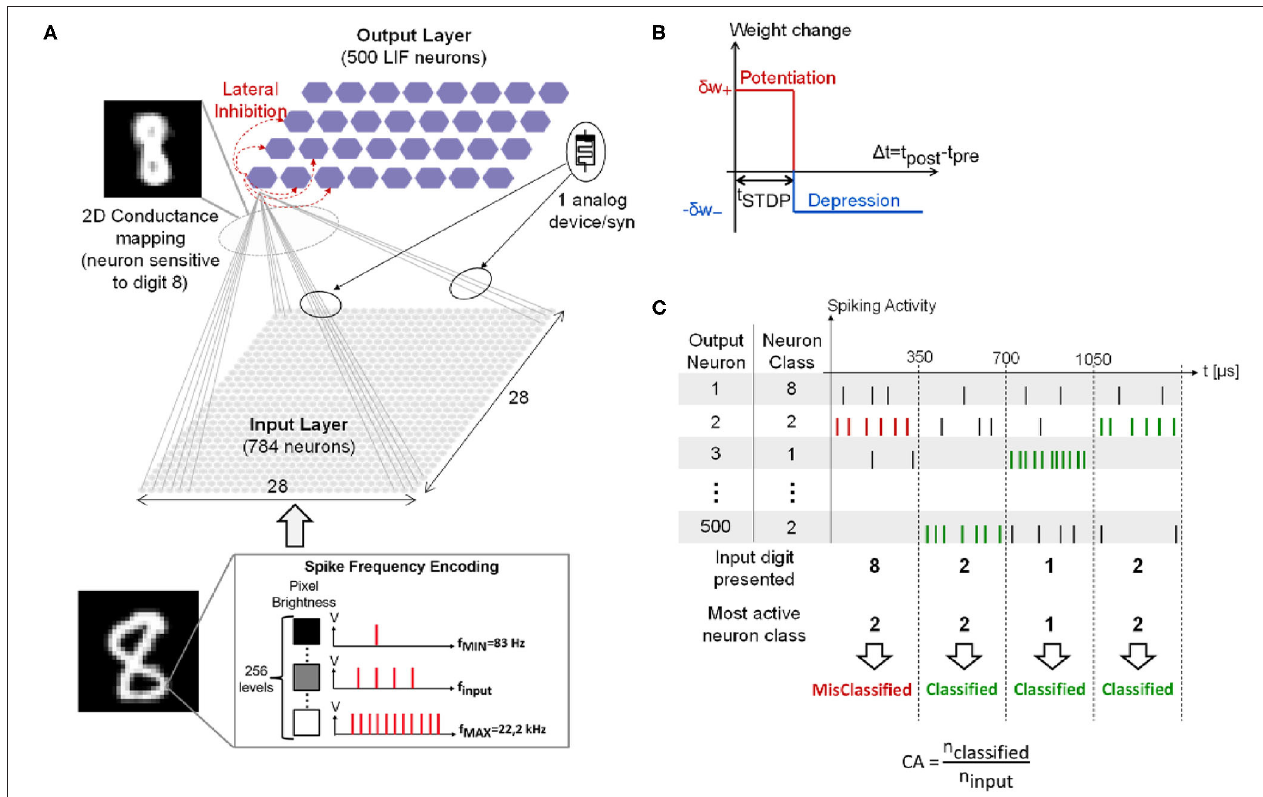
FIGURE 1 | (A) Simulated SNN for the MNIST classification. (B) Simplified STDP learning rule. (C) Example of spiking activity of four output neurons when four different input digits are presented, and Classification Accuracy ( CA ) definition. Adapted with permission from Ly et al. (2018). @IOP Publishing (2018). All rights